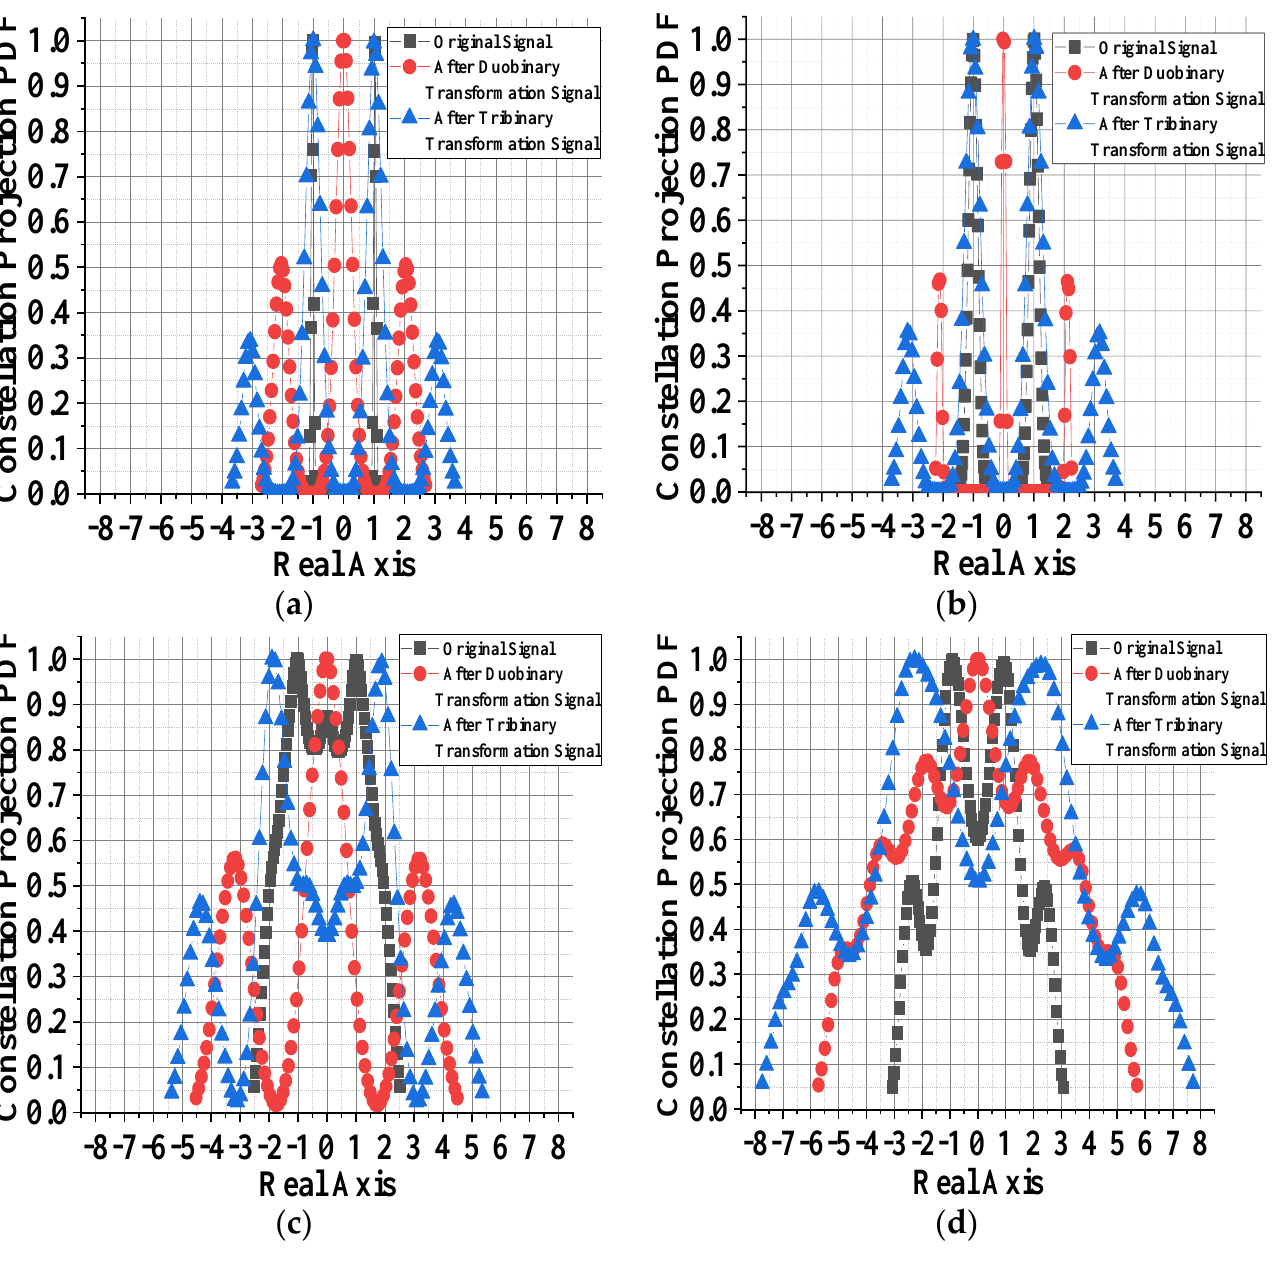
Figure 7. The normalized frequent and continuous versus real values of constellation points for original signal, after duobinary transformation and after tribinary transformation ( a ) when the time- packing factor equals 1.00; ( b ) when the time-packing factor equals 0.95; ( c ) when the time-packing factor equals 0.60; ( d ) when the time-packing factor equals 0.45. The signal has no distortion effect induced by ISI with the time-packing factor of 1.00.